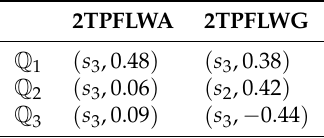
Table 3. Alternatives score values.